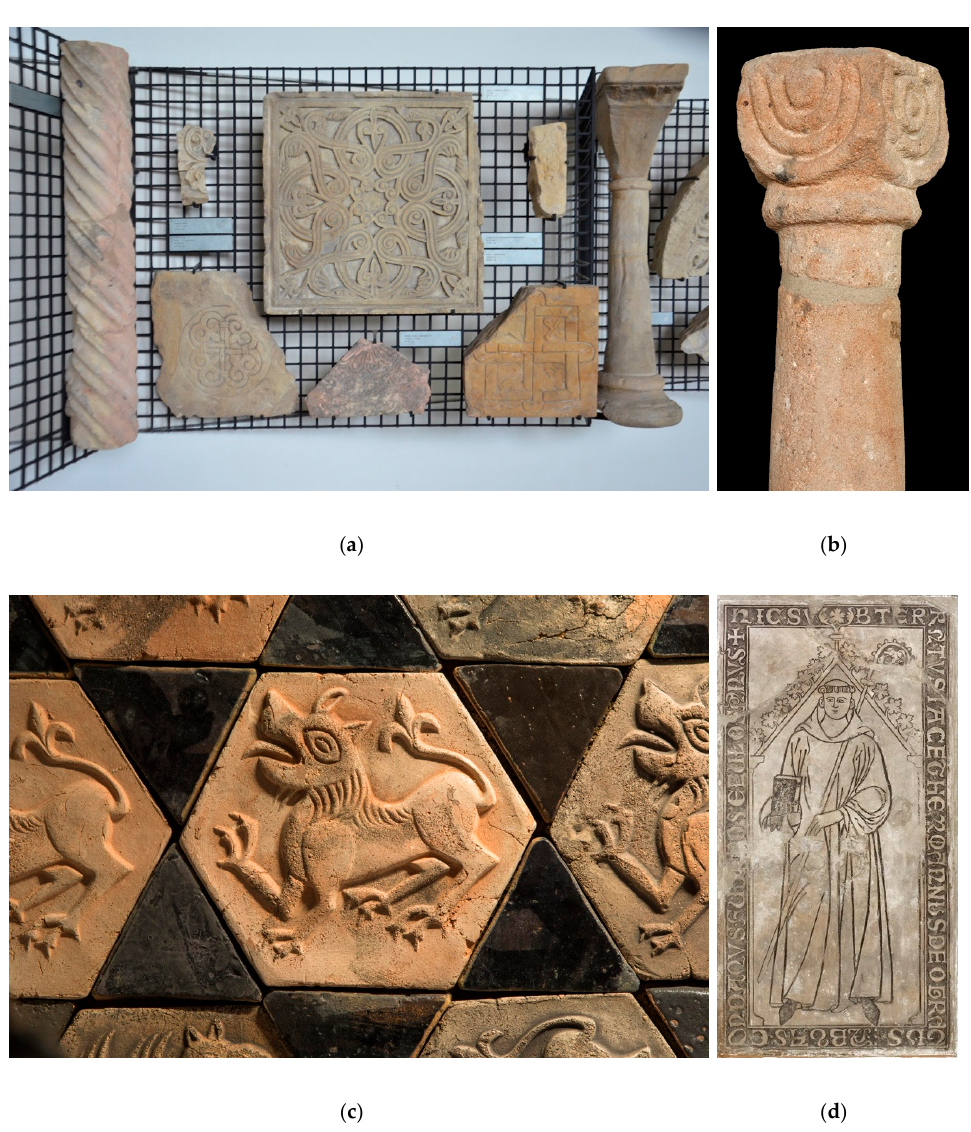
Figure 3. Various historical sources employed: ( a ) Presentation of artefacts in the National Museum in Prague; ( b ) The Romanesque pillar of the National Museum collection; ( c ) The hexagonal tiles of so-called Vyšehrad type; ( d ) The tombstone of abbot Heˇrman. Photos: Petr Kˇr í ž and Tom á š Palat ý